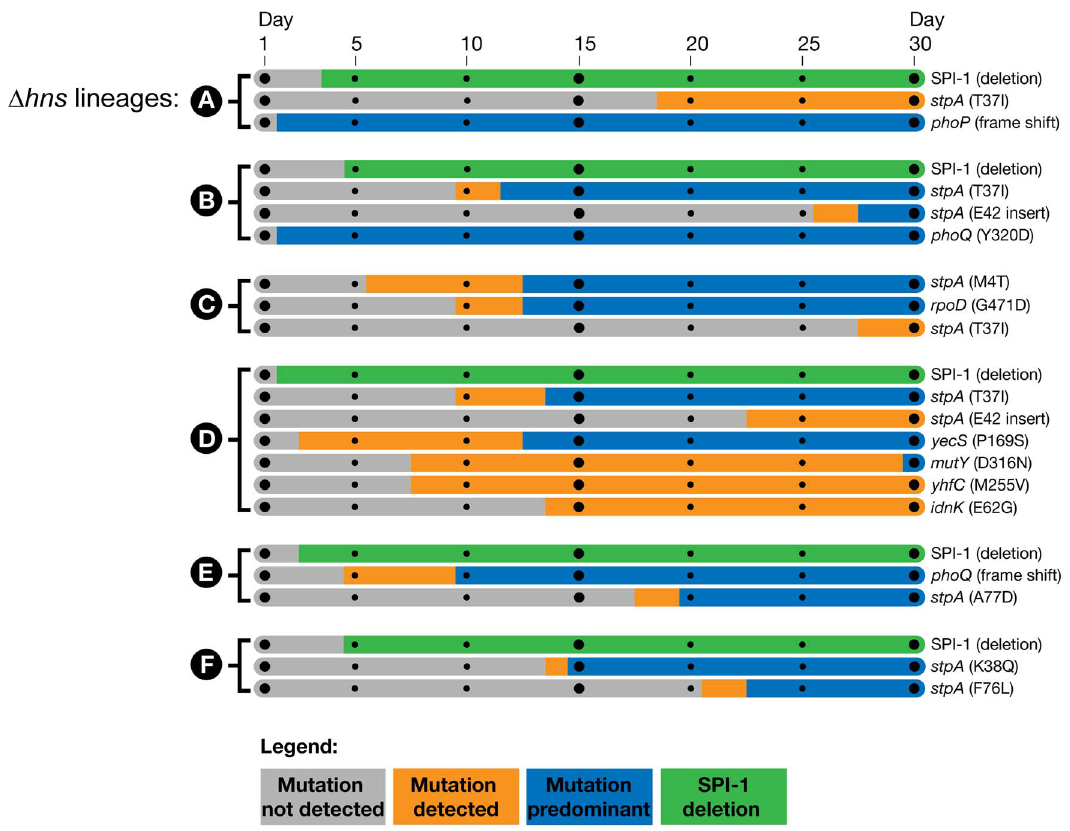
Figure 3. Timeline of the genetic changes in the hns mutant lineages. The mutations present in the hns mutant lineages at day 30 of the passaging period were detected by whole genome sequencing of the mixed populations. The identified genes of interest were PCR amplified directly from samples of the frozen daily culture stocks. The PCR products were sequenced and the relative signal intensities of the wild type vs. mutant alleles from each daily stock were used to estimate when the mutations emerged and became dominant in each population. Bars shaded in grey indicate the mutation was not detected via PCR sequencing, the orange bars indicate the mutation was detected in a fraction of the sequencing reads ( , 50%) and the blue bars indicate the mutant allele was predominant in the population ( . 50%). The large SPI-1 chromosomal deletions were detected by the appearance of a PCR product from the frozen stocks that spanned the deleted region. The green bars indicate detection of the SPI-1 deletions, the method employed did enable approximation of their abundance in the